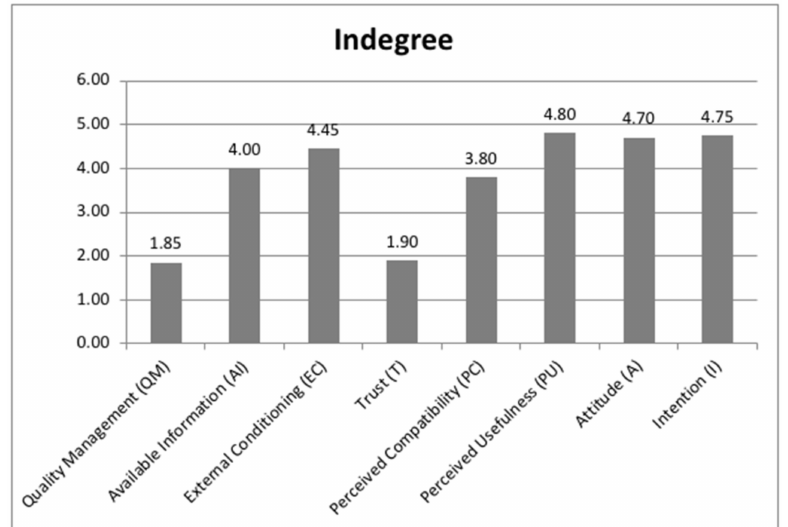
Figure 2. Indicators of the fuzzy cognitive map: indegree. Its values were used to measure the degree of influences that a factor received from the other factors, and the software gave the highest value (4.80) to perceived usefulness (PU) and the lowest value (1.85) to quality management (QM); the rest were found above the mean of these two factors (3.325) minus trust (T)